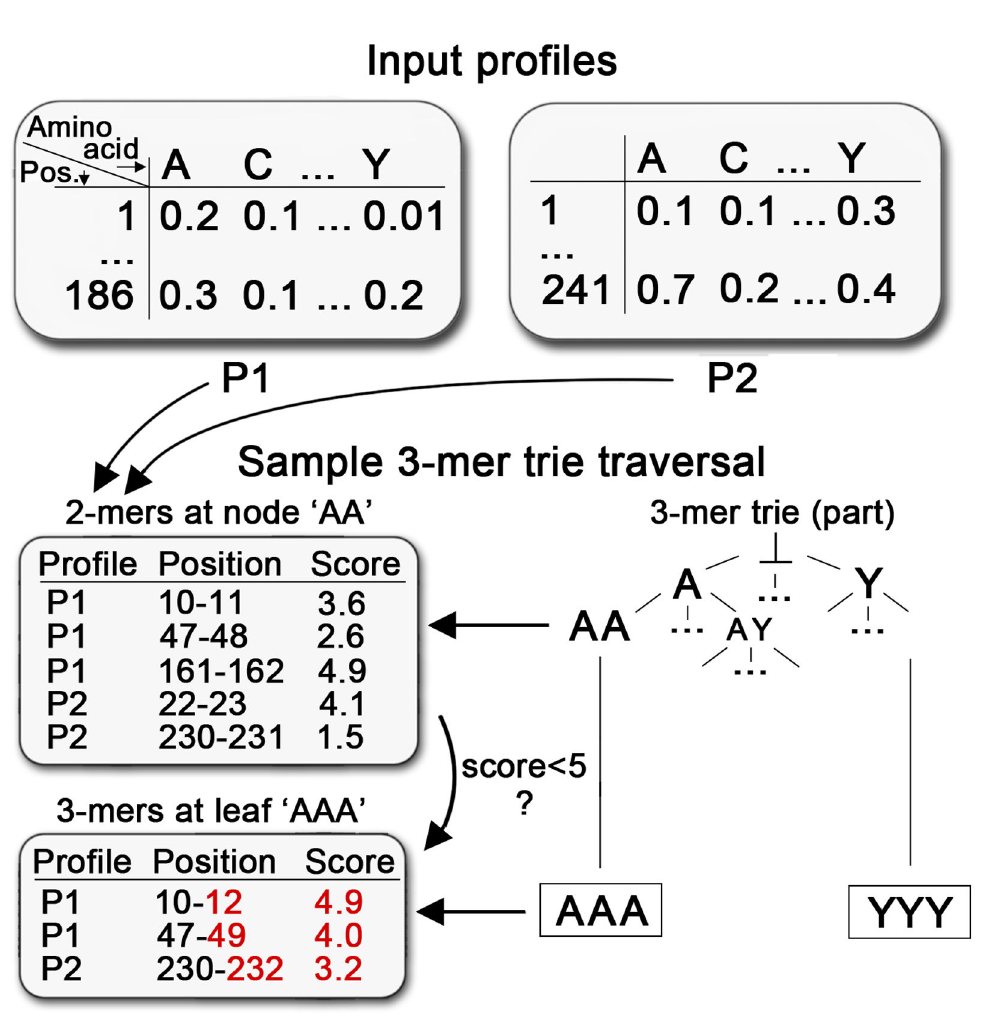
Figure 1. Sample k-mer tree traversal. Sketched is one part of a 3-mer trie traversal with two input profiles (P1 and P2). These profiles were generated with proteins that were 186 (P1) and 241 residues long (P2; tables on the top). During traversal, some conserved multi-mers remain at each node that fall below the substitution score threshold σ. The ‘Sample 3-mer trie traversal’ illustrates the transition from two-letter node ‘AA’ to node ‘AAA’ (‘AAA’ is also a leaf, because k=3). At node ‘AA’, five 2-mers have remained from previous transitions (root -> ‘A’ -> ‘AA’) that still fall below the substitution score threshold σ=5. In the transition to node ‘AAA’, each such 2-mer is extended to a 3-mer and each score re-calculated (k-mer extension and new scores in red). 3-mers with a score > 5 are discarded (2/5) and those that remain (3/5) are used in the kernel matrix update. Afterwards, the traversal continues until reaching the lexicographically last leaf